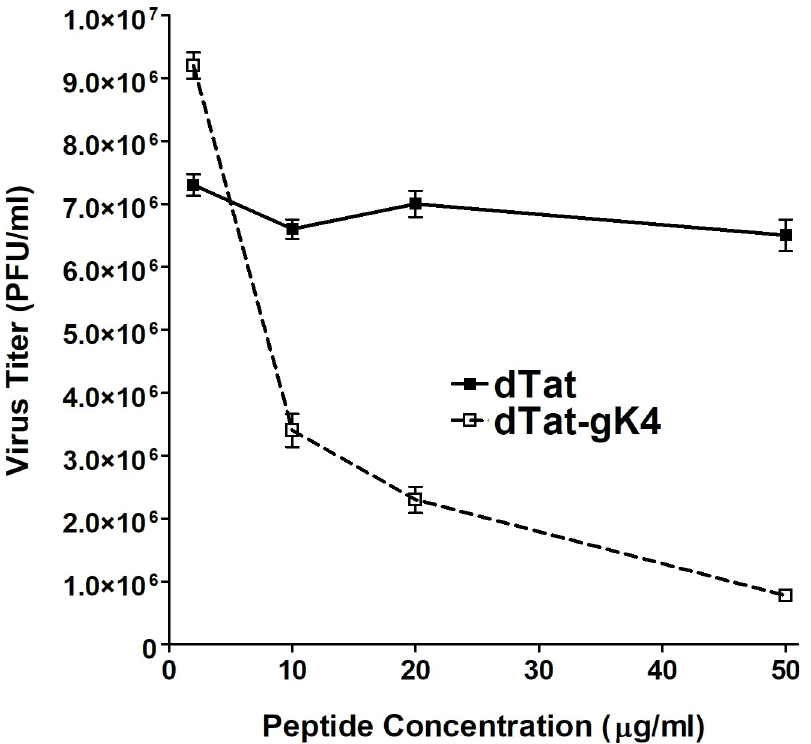
1hr infection, the media was replaced with fresh media containing each peptide. Infected cells were harvested 24 hr PI and virus titer was measured by standard plaque assay. Virus replication was significantly inhibited by dTat-gK4 peptide in a dose dependent manner. Half maximal effective concentration (EC 50) of dTat-gK4 peptide was around 2.1 μ M (6.6 μ